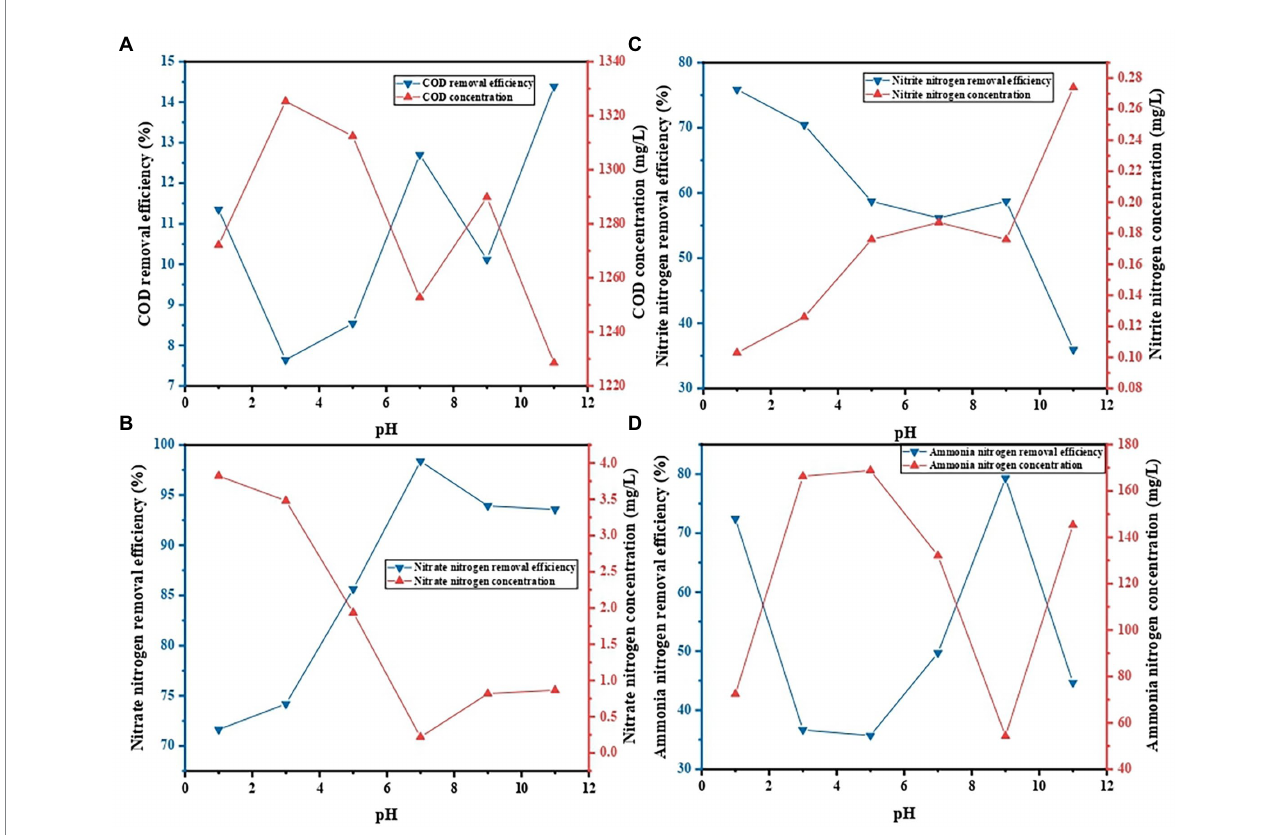
FIGURE 7 Effect of initial pH on contaminant removal: (A) COD removal, (B) NO 3 − -N removal, (C) NO 2 − -N removal, and (D) NH 4+ -N